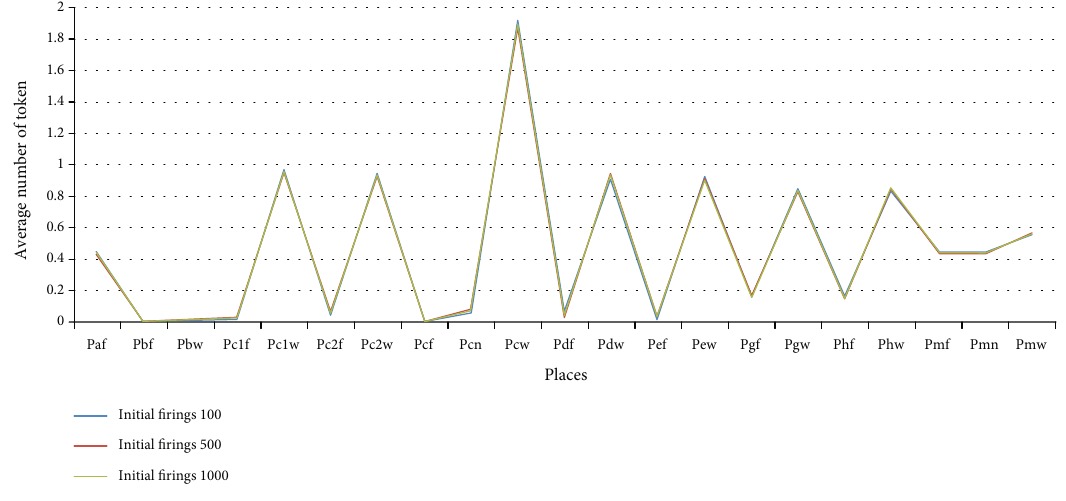
Figure 10: Token distribution of di ff erent number of fi